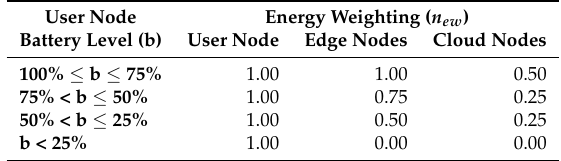
Figure 4. Case study of AR applications. Table 1. Policy of energy weighting according to the battery level of the users’ nodes.